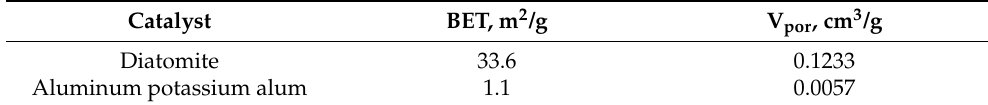
Table 3. Properties surfaces of the tested materials. Catalyst BET, m 2 /g V por , cm 3 /g Diatomite